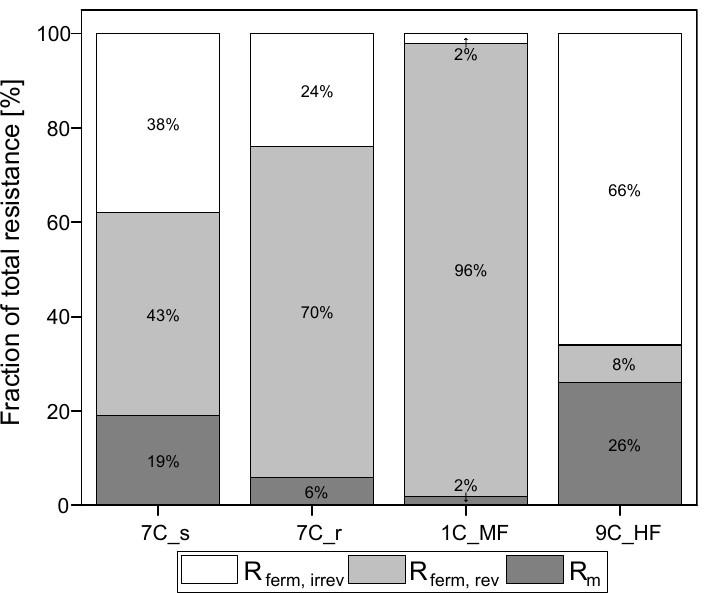
Figure 6. Partition of resistances caused by the filtration of fermentation broth. The sum of the reversible and irreversible resistance is R ferm . The sum of R m and R ferm is R ferm, tot . The 100% values correspond to a total resistance R ferm, tot of 5.04 × 10 12 m − 1 for 7C_s, 5.52 × 10 12 m − 1 for 7C_r, 5.38 × 10 12 m − 1 for 1C_M, and 3.81 × 10 12 m − 1 for 9C_HF. Irreversible resistance as a proportion of total resistance ranged from 66% for the ceramic UF hollow-fiber membrane to 2% for the MF membrane 1C_MF, with the 7C_s and 7C_r membranes showing intermediate values of 38% and 24%, respectively. The membrane with the highest steady-state flux therefore also showed the highest proportion of irreversible resistance. In contrast, membrane 1C_MF (with the largest pore size of 200 nm) showed the lowest proportion of irreversible resistance. Among the 30 nm membranes (7C_s, 7C_r and 9C_HF), the partitioning of resistance varied independently of pore size. 3.6. Filtration of Medium-Free K. lactis Cell Suspension To investigate the influence of surface roughness and the number and thickness of separating layers in more detail, the fermentation broth was fractionated into the two main components medium and yeast cells. Figure 7a shows the TRM flux curves using K. lactis cells as a feed at a CFV of 0.8 m s -1 and the biomass remaining in the retentate based on the Δ OD 600 . The corresponding percentage resistances are shown in Figure 7b. The absolute values of resistances caused by the filtration of K. lactis cells are provided in Supplementary Material S1.3. The filtration of 2.5 g L − 1 K. lactis cells reached steady-state flux after 240 min for membrane 7C_s (J ss = 24 L m − 2 h − 1 ) and 350 min for membrane 7C_r (J ss = 20 L m − 2 h − 1 ), corresponding to 85% and 93% flux loss, respectively. These fluxes were lower than those observed for the complete fermentation broth, and it took considerably longer to reach J ss . The irreversible fraction of total resistance was 15% for both membranes, although the biomass concentration in the retentate differed between the membranes we used. The biomass in the retentate was reduced by ~25% for membrane 7C_s but ~50% for membrane 7C_r. At the end of filtration, immediate flushing of the membrane for 5 min at a CFV of 0.8 m s − 1 with the permeate valve closed restored the initial amount of biomass for both membranes.